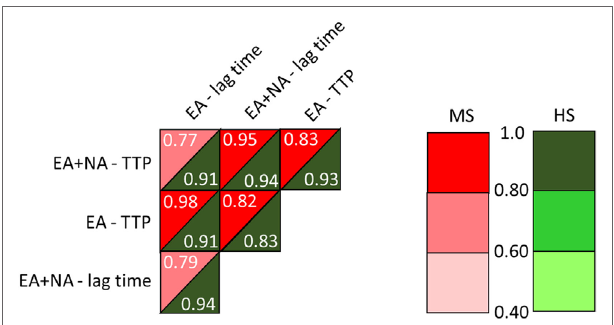
FigUre 2 | Correlations between time parameters from the intrinsic thrombin generation (TG) triggered by EA or by ellagic plus NA. MS, multiple sclerosis; HS, healthy subjects; EA, ellagic acid; NA, nucleic acid; TTP, time to peak. Linear models were generated to determine the relationship between TG